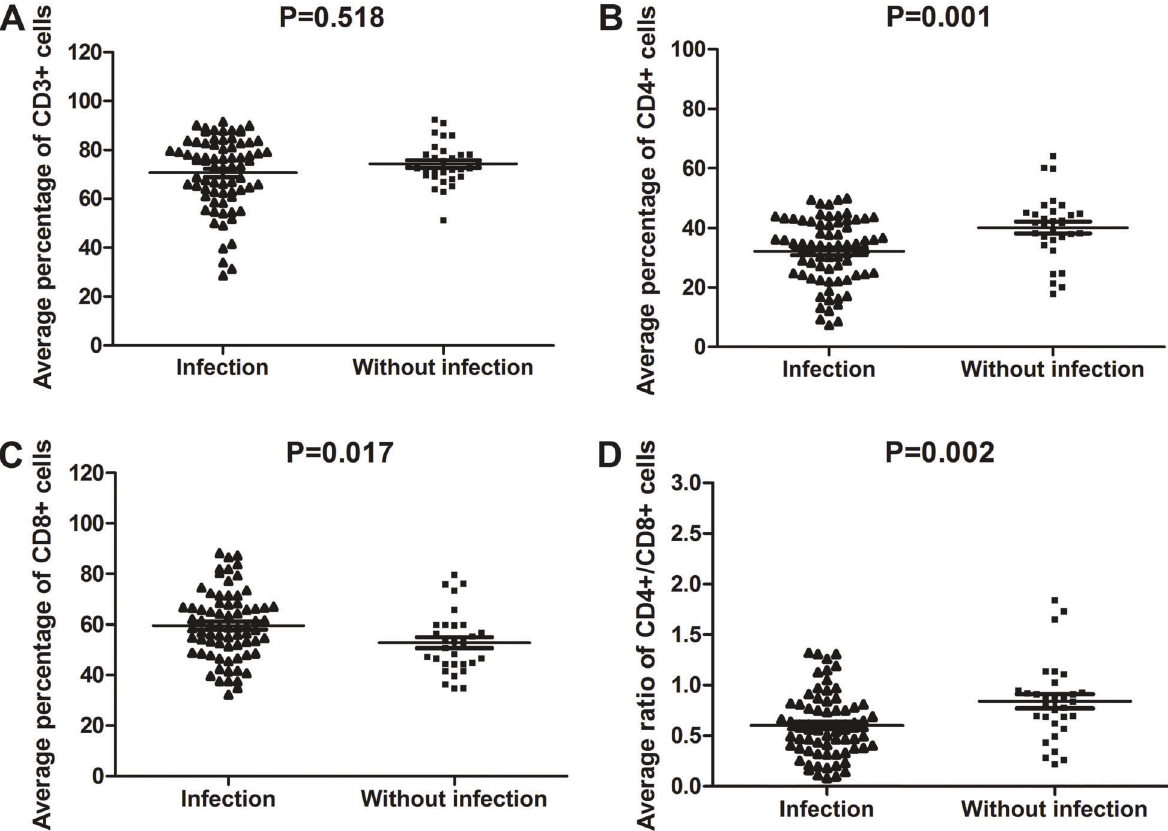
Figure 1. T cell subset levels in 73 systemic lupus erythematosus (SLE) patients with infection and 31 SLE patients without infection. Flow cytometry was used to test Tcell subsets. A , percentage of CD3 + Tcells. B , percentage of CD4 + Tcells. C , percentage of CD8 + T cells. D , CD4 + /CD8 + T cells ratio (Mann-Whitney U or